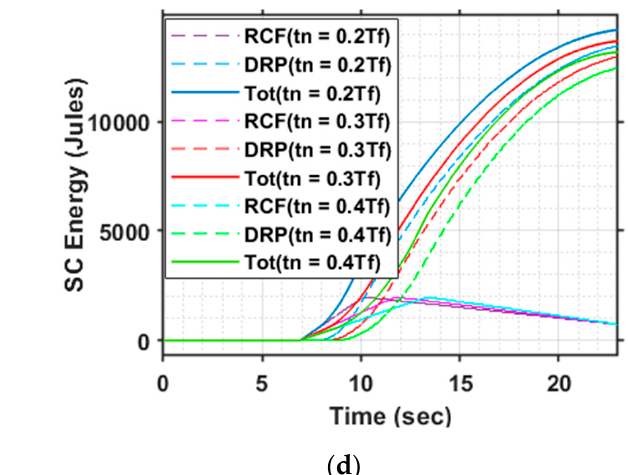
and its impact on sizing of the SC nadir